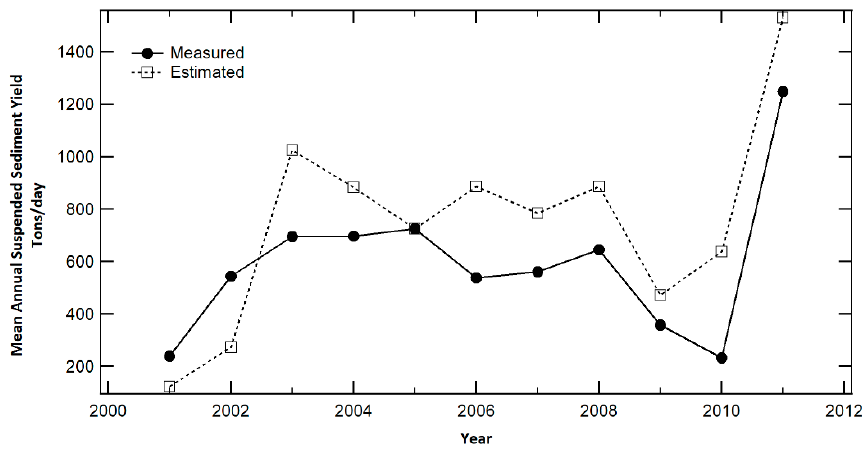
Figure 8. Comparison of estimated and measured suspended sediment yield.